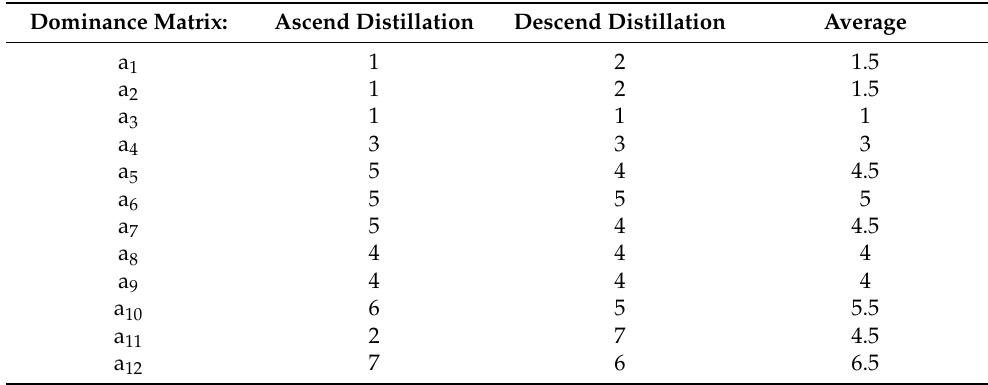
Table 8. Final ranking.